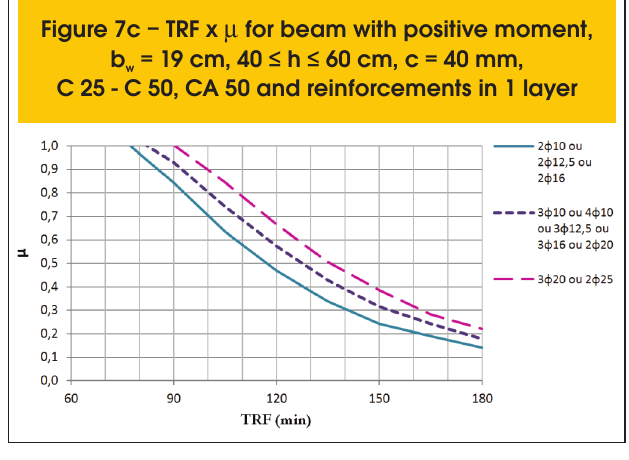
Figure 7d – TRF x m for beam with positive moment, b = 25 cm, 40 ≤ h ≤ 60 cm, c = 25 mm, w C 25 - C 50, CA 50 and reinforcements in 1